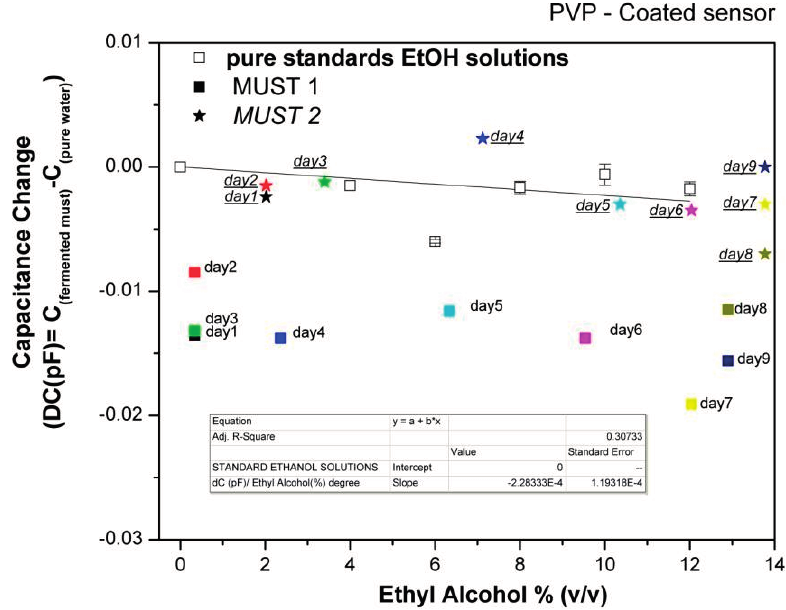
Figure 8. Equilibrium responses of a relative hydrophilic polymer-coated sensor upon exposure to the headspace of pure ethanol solutions in comparison with data of